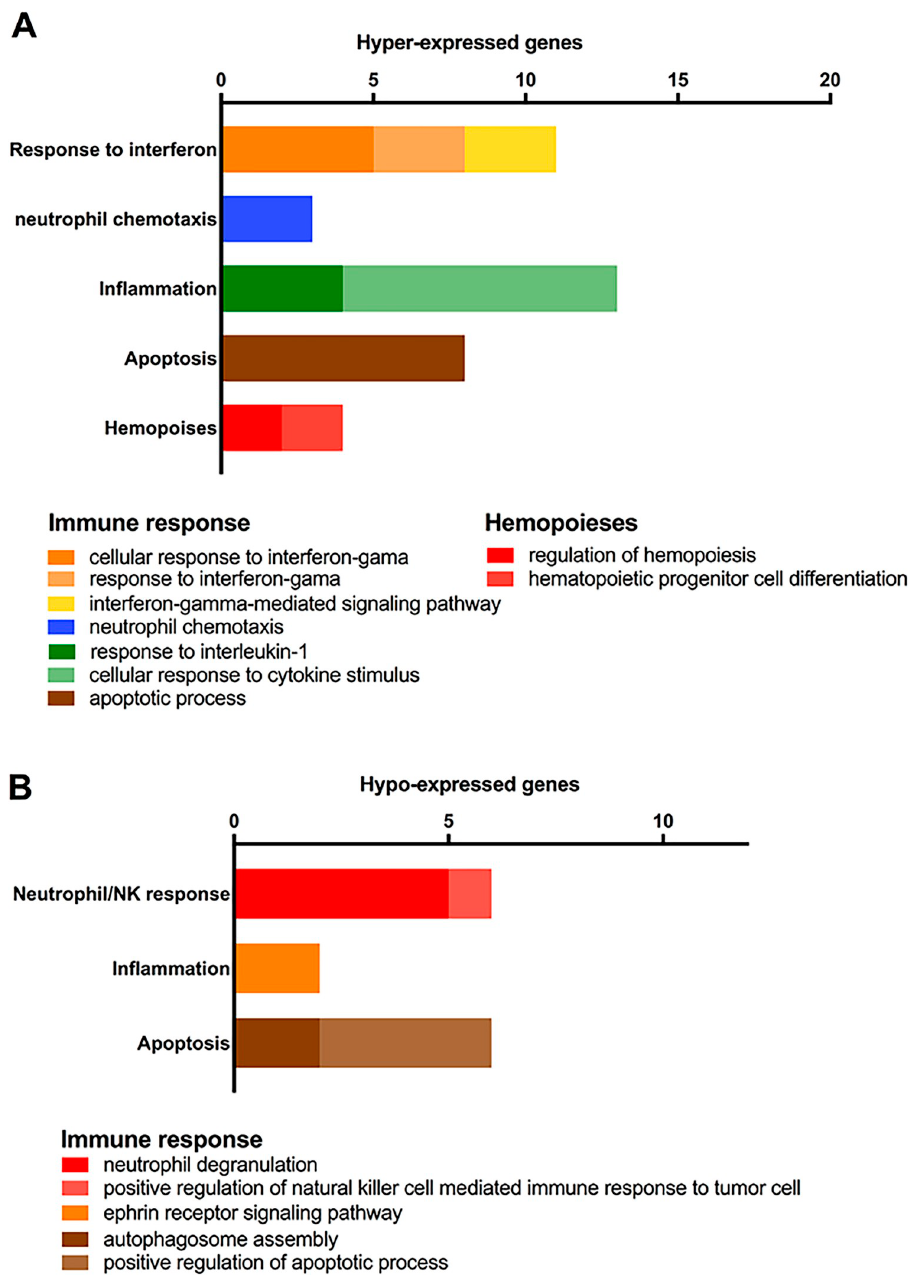
Fig 1. Enrichment analysis for DE genes. Gene categorization and distribution according to the terms listed for Biological Process in the Gene Ontology database (p < 0.05). Hyper- ( A ) and hypo-expressed ( B ) genes in the HRSV